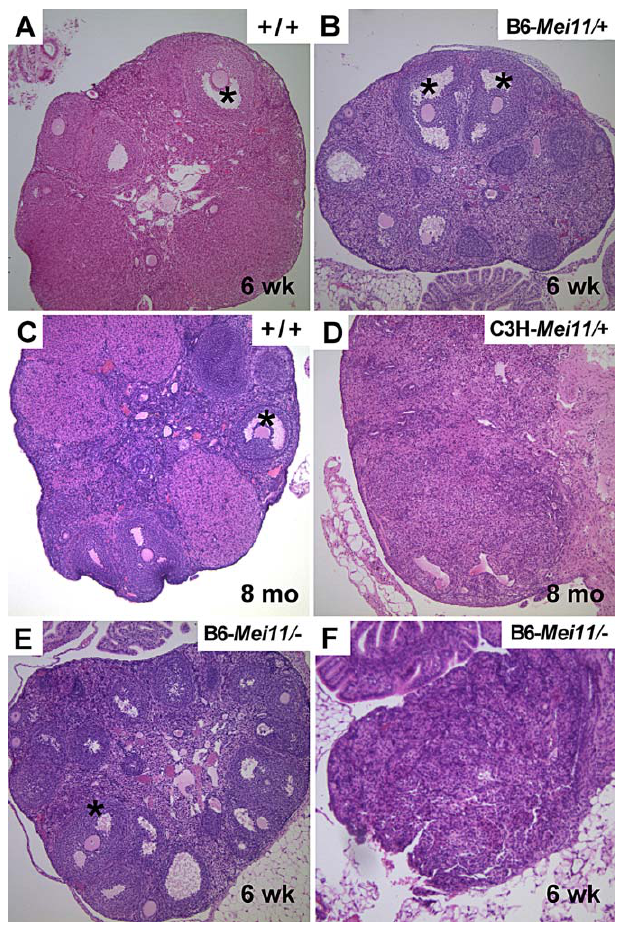
Figure 3. Histopathology of Mutant Ovaries Shown are hematoxylin and eosin–stained paraffin sections of ovaries. The genotypes and ages of the females from which the ovaries were taken are indicated in each panel. Examples of antral-stage follicles with clear oocyte nuclei are indicated with asterisks. Dmc1 Mei11 is abbreviated as Mei11, and þ or (cid:3) in genotypes refers to the wt or null alleles of Dmc1, respectively. The ovary in (F) is more severely affected than from a female of the same genotype in (E).